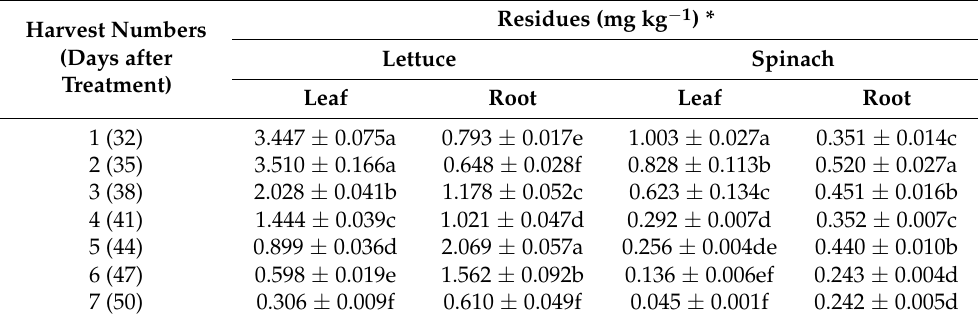
Table 3. Imicyafos residues in the plant leaf and root samples during the harvest time.